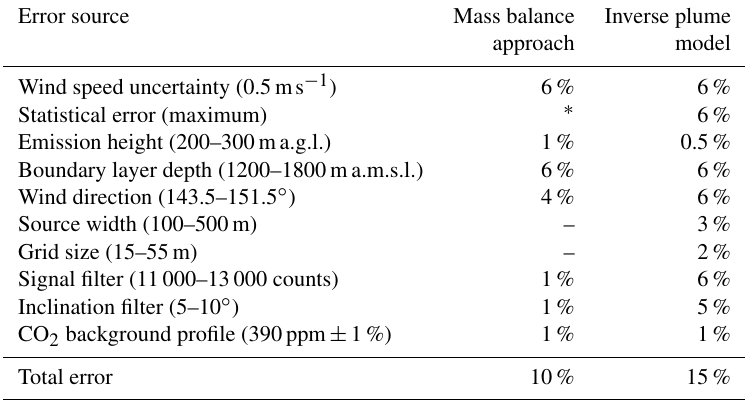
Table 2. Overview of maximum absolute values of the different error components of the estimated emission rates for the remote sensing results. The uncertainties are derived from a sensitivity analysis and the total error is the root sum square of the individual error components. In the case of the mass balance approach an additional uncertainty can be derived from the scatter of inversions for individual tracks (see Fig.15 and Sect.